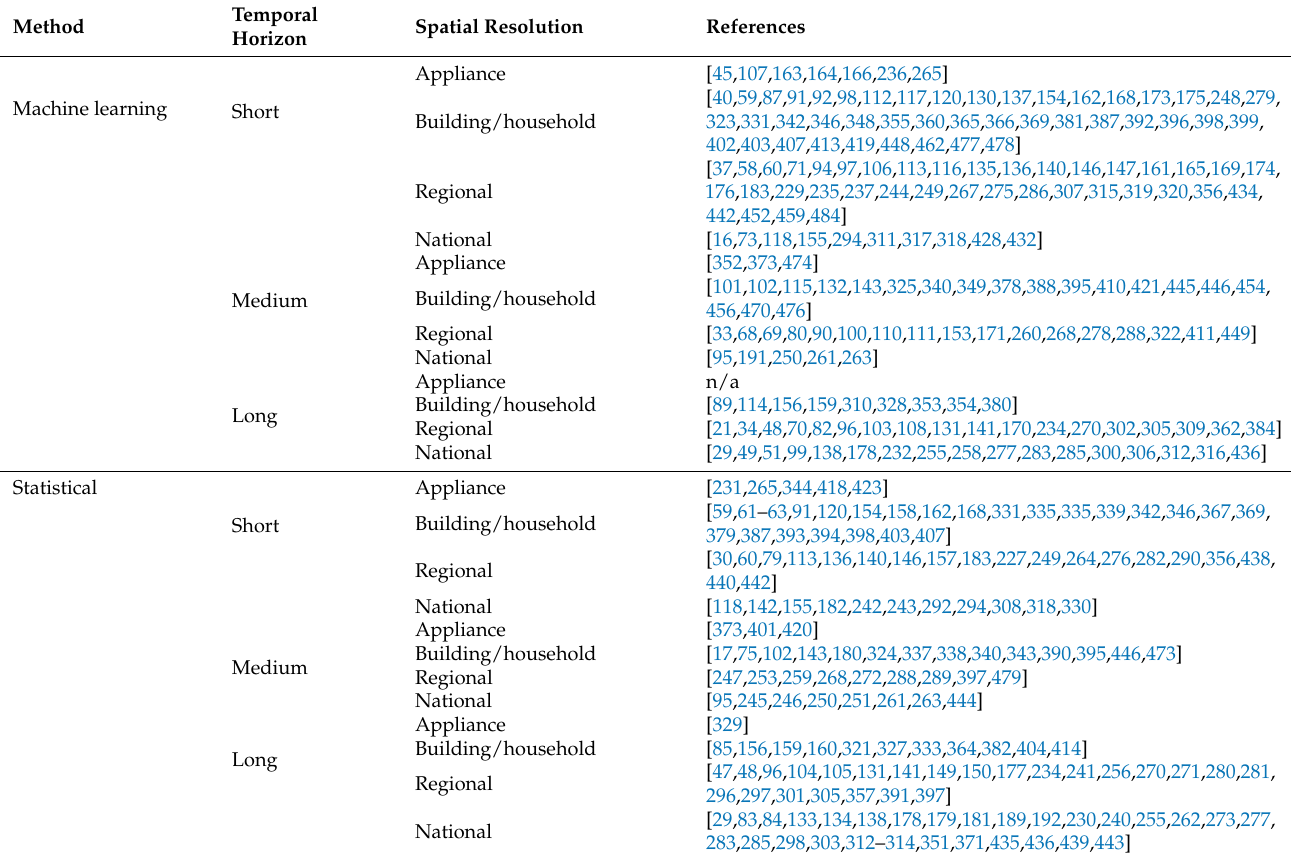
Table A8. Techniques and level of detail per article (1/2). Compiled results of the analysis on techniques, temporal horizon, and spatial resolution. The table follows a matrix structure: all articles referenced within a cell rely on the category of techniques specified.